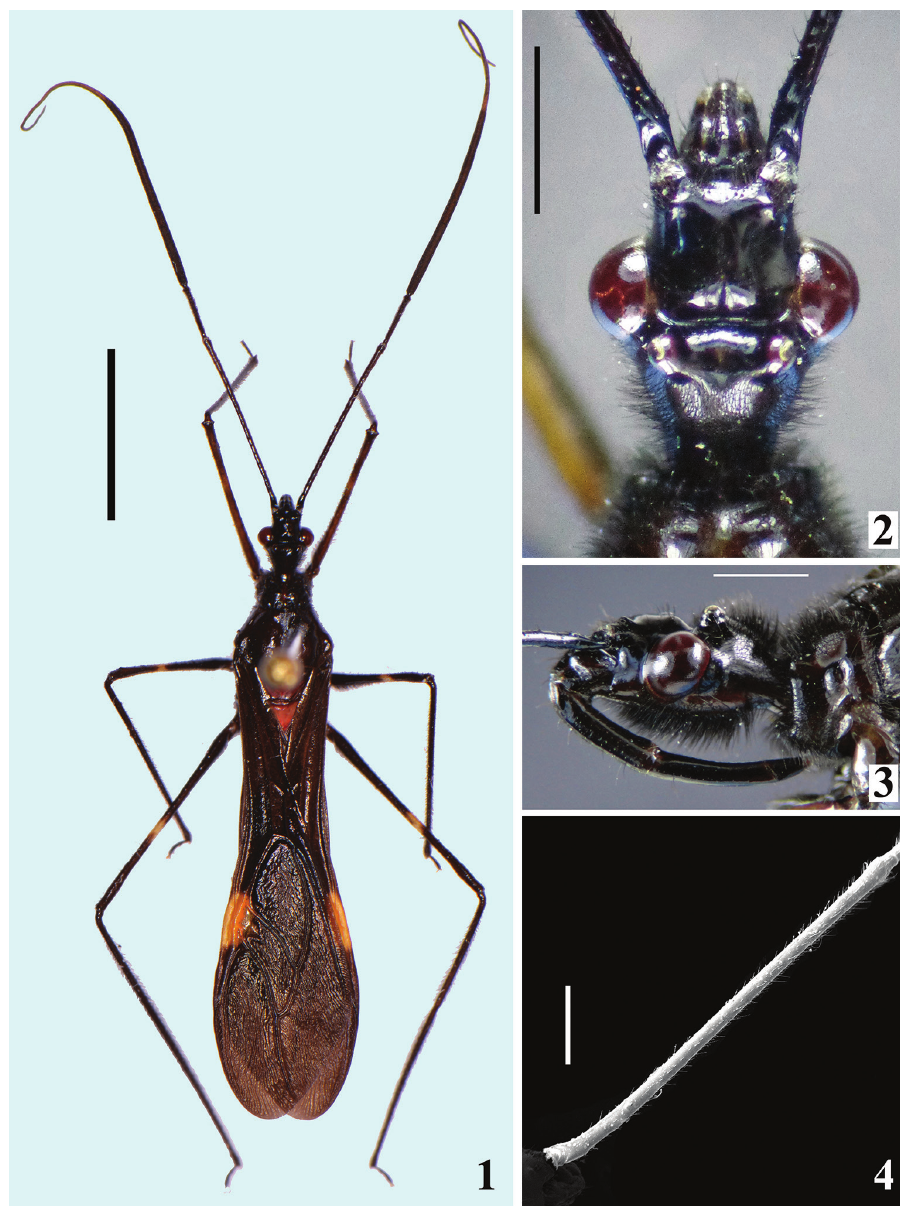
Figures 1–4. Parahiranetis salgadoi Gil-Santana, male. 1 dorsal view 2–3 head 2 dorsal view 3 lateral view 4 antennal segment I, lateral view. Scale bars: 5.0 mm ( 1 ); 1.0 mm ( 2–4 ). Fore femur black to dark brown, frequently with dorsal surface paler, with dark